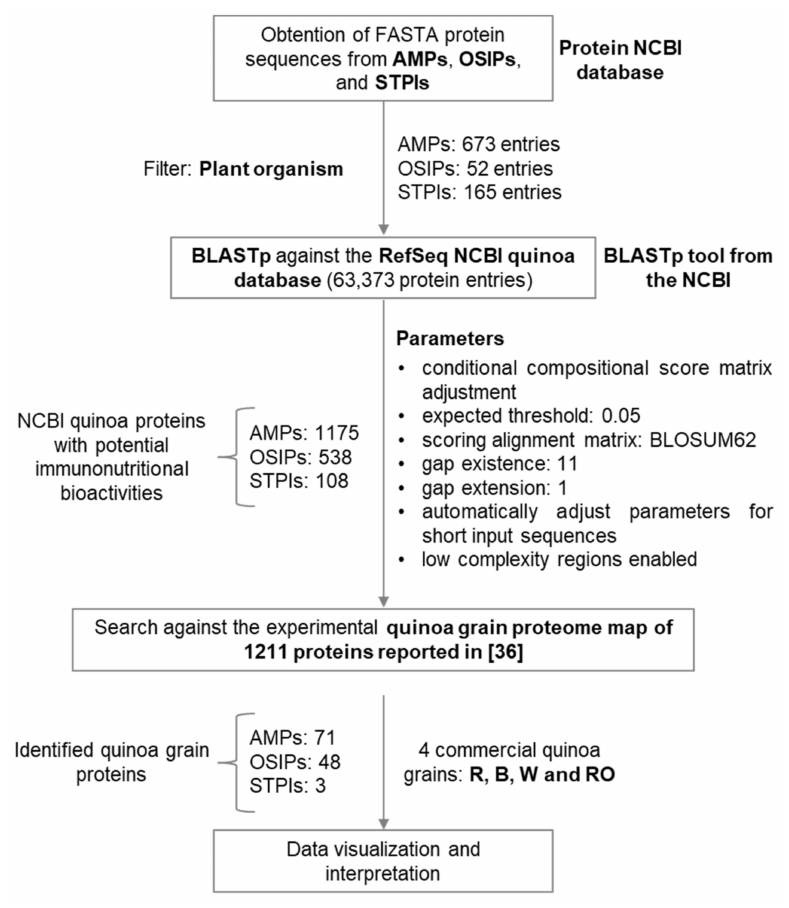
Figure 1. Schematic representation of the proteomics data mining